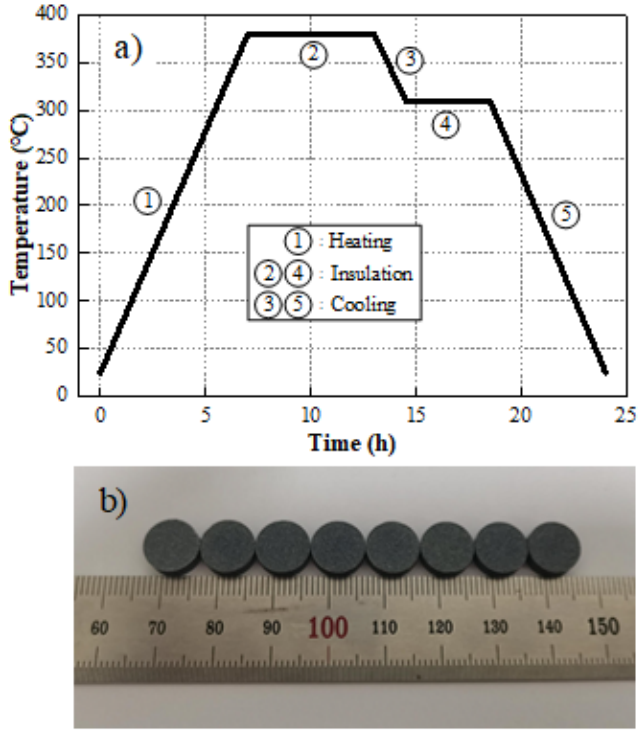
Figure 1. ( a ) Temperature history of the sintering cycle and ( b ) fabricated samples.